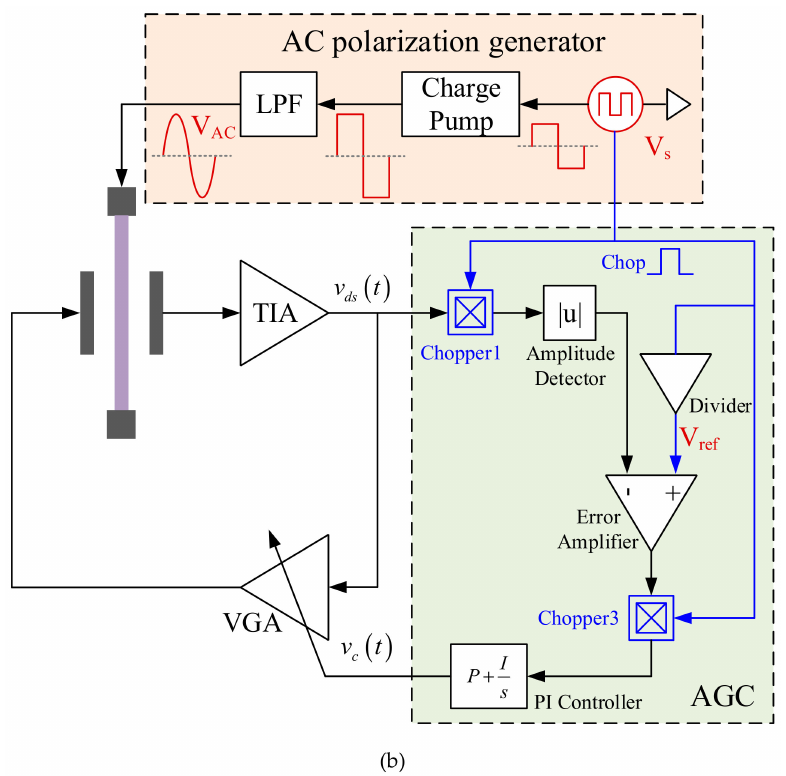
Figure 8. Schematics of closed-loop oscillator with polarization voltage self-compensation under ( a ) DC and ( b ) AC